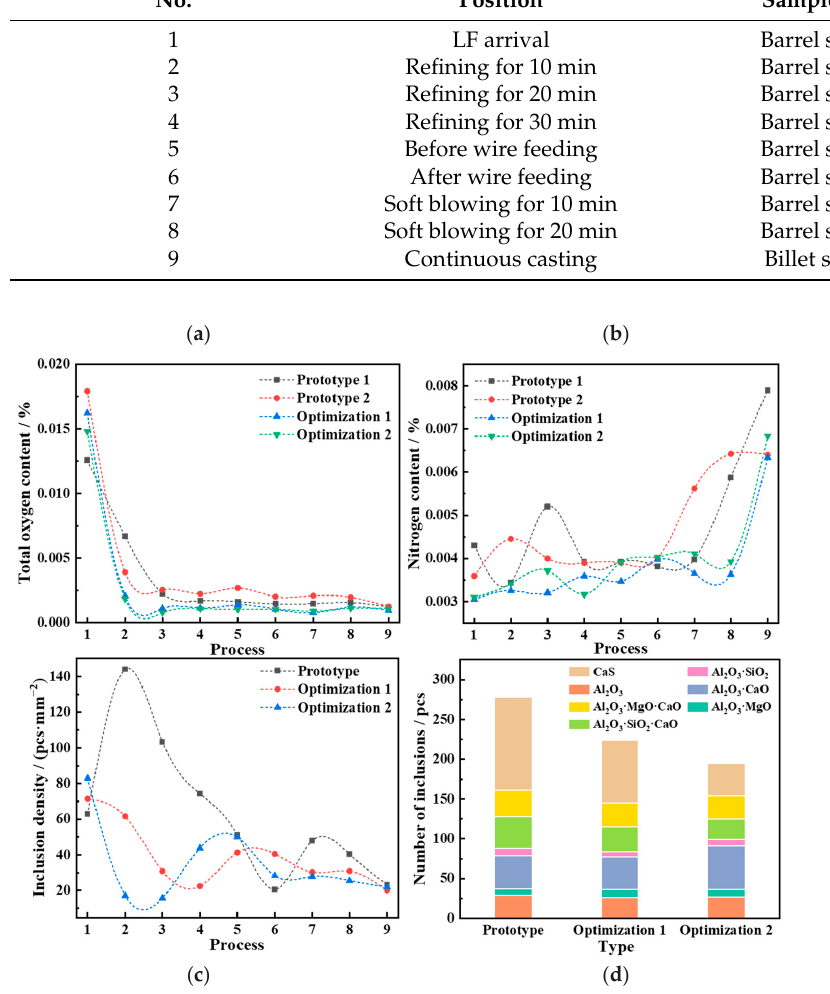
Figure 13. Changes in total oxygen content ( a ), nitrogen content ( b ), inclusion density ( c ) and inclusion type ( d ) of molten steel before and after optimization.